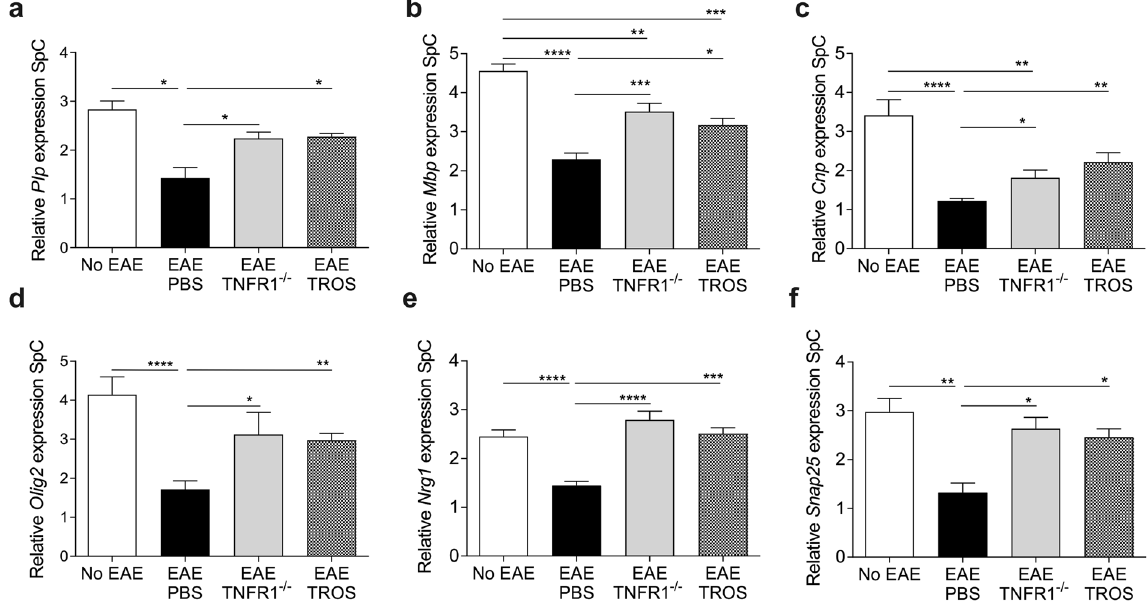
Figure 6. ( a – f ) Therapeutic treatment with TROS is neuroprotective. hTNFR1 Tg and TNFR1 − / − mice were immunized with MOG 35-55 -peptide and pertussis toxin to induce EAE. Spinal cords (SpC) were isolated from healthy hTNFR1 transgenic (Tg) (no EAE, n = 4), EAE-diseased TNFR1 − / − (n = 5), and EAE-diseased hTNFR1 Tg mice 16 days post-immunization (PI). The EAE-diseased hTNFR1 Tg mice were therapeutically treated on days 8 and 12 PI with 500 µ g TROS (n = 4) or PBS (n = 4), injected intraperitoneally. (a – d ) Relative expression of the spinal cord determined by qPCR of myelin-associated and oligodendrocyte-associated genes: proteolipid protein ( Plp ) ( a ), myelin basic protein ( Mbp ) ( b ), cyclic nucleotide phosphodiesterase ( Cnp ) ( c ) and oligodendrocyte transcription factor ( Olig2 ) ( d ). ( e , f ) Relative expression of the spinal cord determined by qPCR of genes involved in synaptic functioning and neuronal integrity: neuregulin 1 ( Nrg1 ) ( e ) and synaptosomal-associated protein 25 ( Snap25 ) ( f ). Data information: qPCR was normalized to stable housekeeping genes. Bars represent mean ± SEM. All data were analyzed with a Mann-Whitney test. * 0.01 ≤ p < 0.05; ** 0.001 ≤ p < 0.01; *** 0.001 ≤ p 0.0001, **** p < 0.0001. Non-statistically significant differences are not indicated on the graphs.